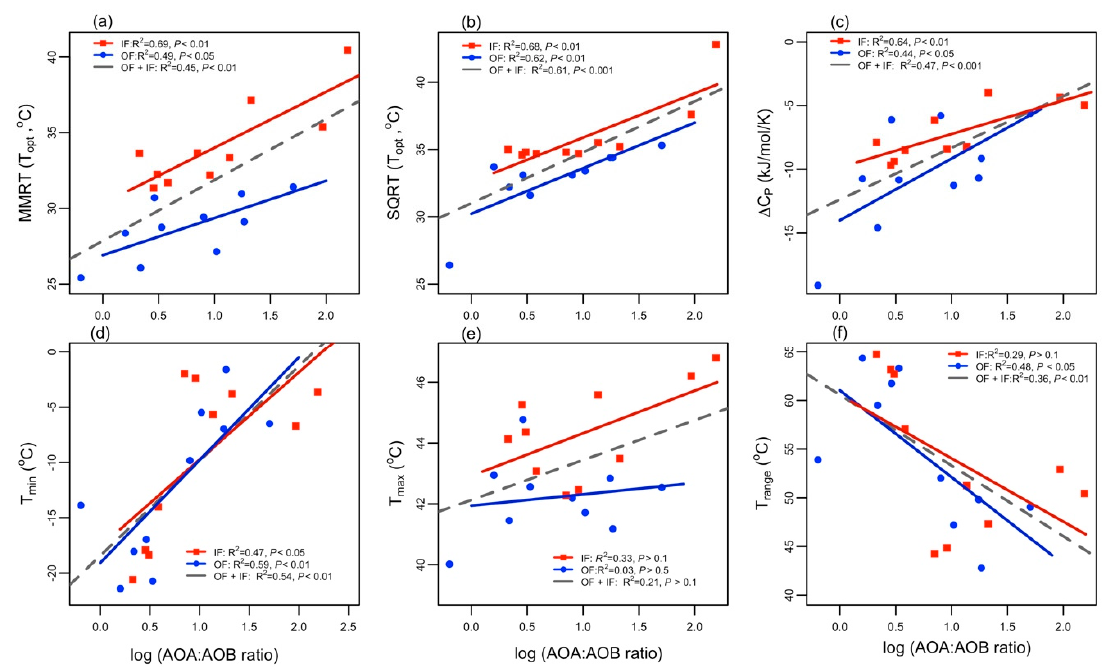
Figure 2. The influence of AOA to AOB ratios on ( a ) mean optimum temperature for nitrification estimated by the macromolecular rate theory (MMRT) model; ( b ) optimum temperature estimated by the square root theory (SQRT)) model; ( c ) change in heat capacity associated with the temperature dependence of nitrification ( ∆ C ); ( d ) theoretical apparent minimum temperature (T min ) for NP activity; ( e ) maximum temperature (T max ) for NP activity; and ( f ) temperature range (T max –T min ). “OF” and “IF” represent the soil samples from organic and inorganic fertilized soils, respectively.